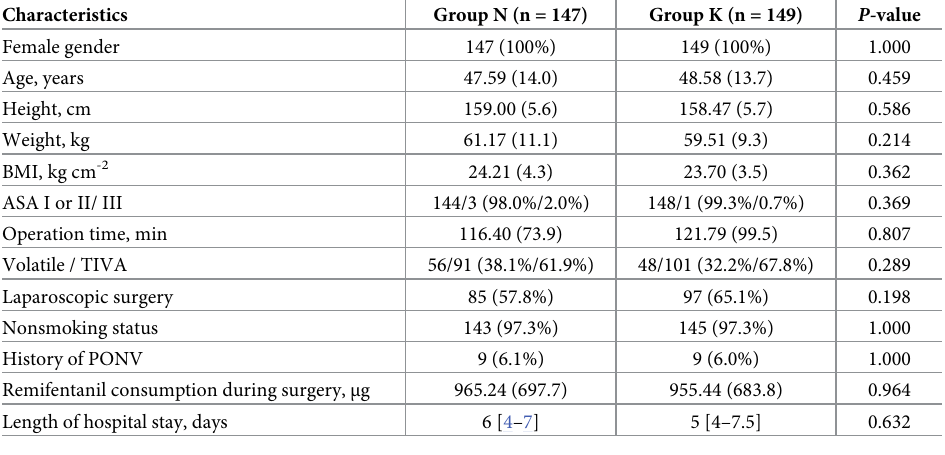
Table 2. Characteristics of patients receiving intravenous patient-controlled analgesia containing either nefopam and fentanyl or ketorolac and fentanyl.